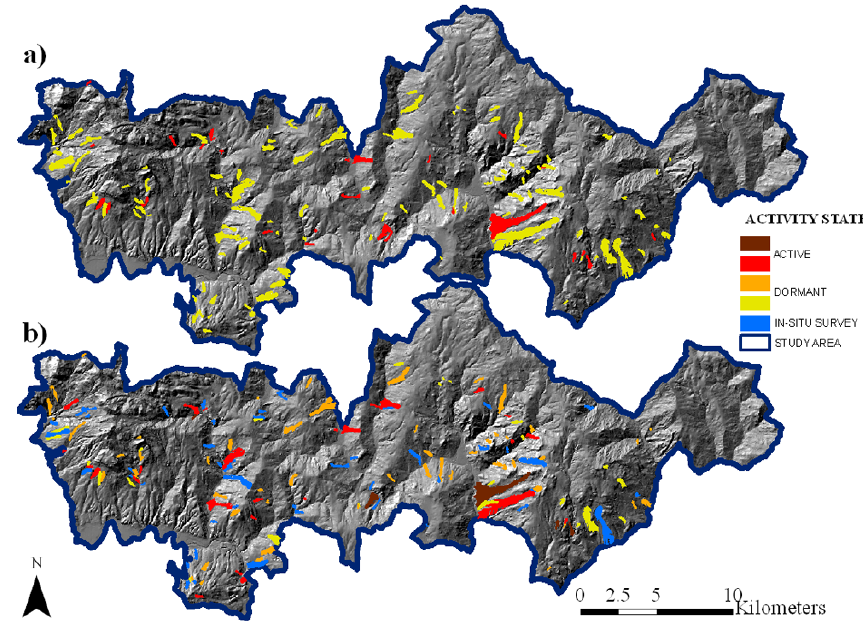
Fig. 21. Results of the application of the DInSAR-Damage matrix: the pre-existing (a) and the updated (b) landslide state of activity.